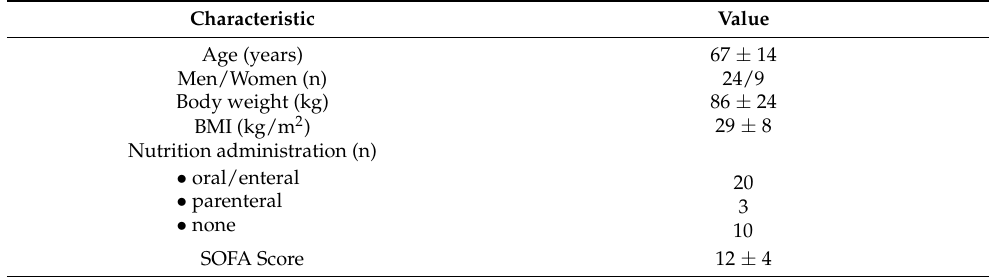
Table 2. Patient characteristics.